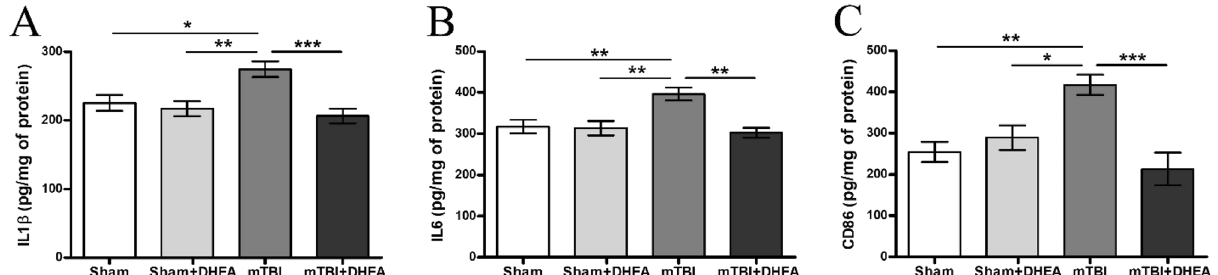
Figure 3. In vivo effect of DHEA on pro-inflammatory responses in mTBI. Level of ( A ) IL1β, ( B ) IL6, ( C ) CD86 expression in the cerebral cortex. Data are the mean ± SEM, n = 7/group, * P < 0.05, ** P < 0.01 and *** P < 0.001 (one-way ANOVA, post-test Tukey). Images were prepared with using GIMP 2.10.22 software